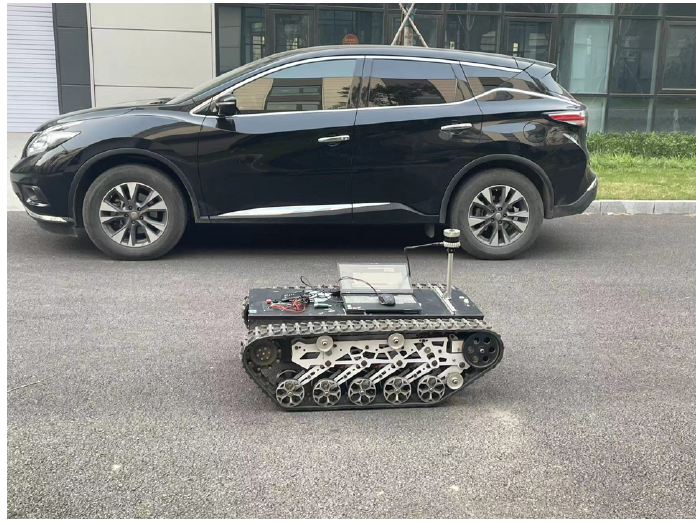
Figure 17. Road conditions with real obstacles on the left side.